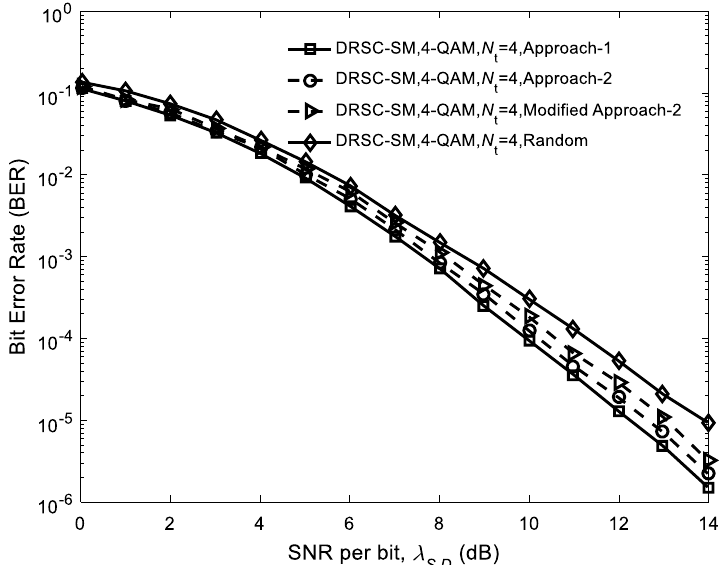
Fig. 6 Performance of DRSC-SM scheme (4-QAM) with RS 1 ( 15,13 ) and RS 2 ( 15,7 ) under different approaches. The solid line with diamond mark denotes the BER performance of DRSC-SM scheme under random approach. The dashed line with circle mark denotes the BER performance of DRSC-SM scheme under Approach 2. The dashed line with right triangle mark denotes the BER performance of DRSC-SM scheme under modified Approach 2. The solid line with square mark denotes the BER performance of